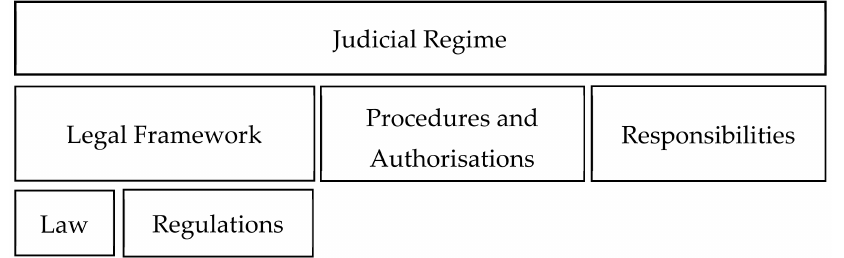
Figure 3. Elements of a judicial regime in Spain [14].